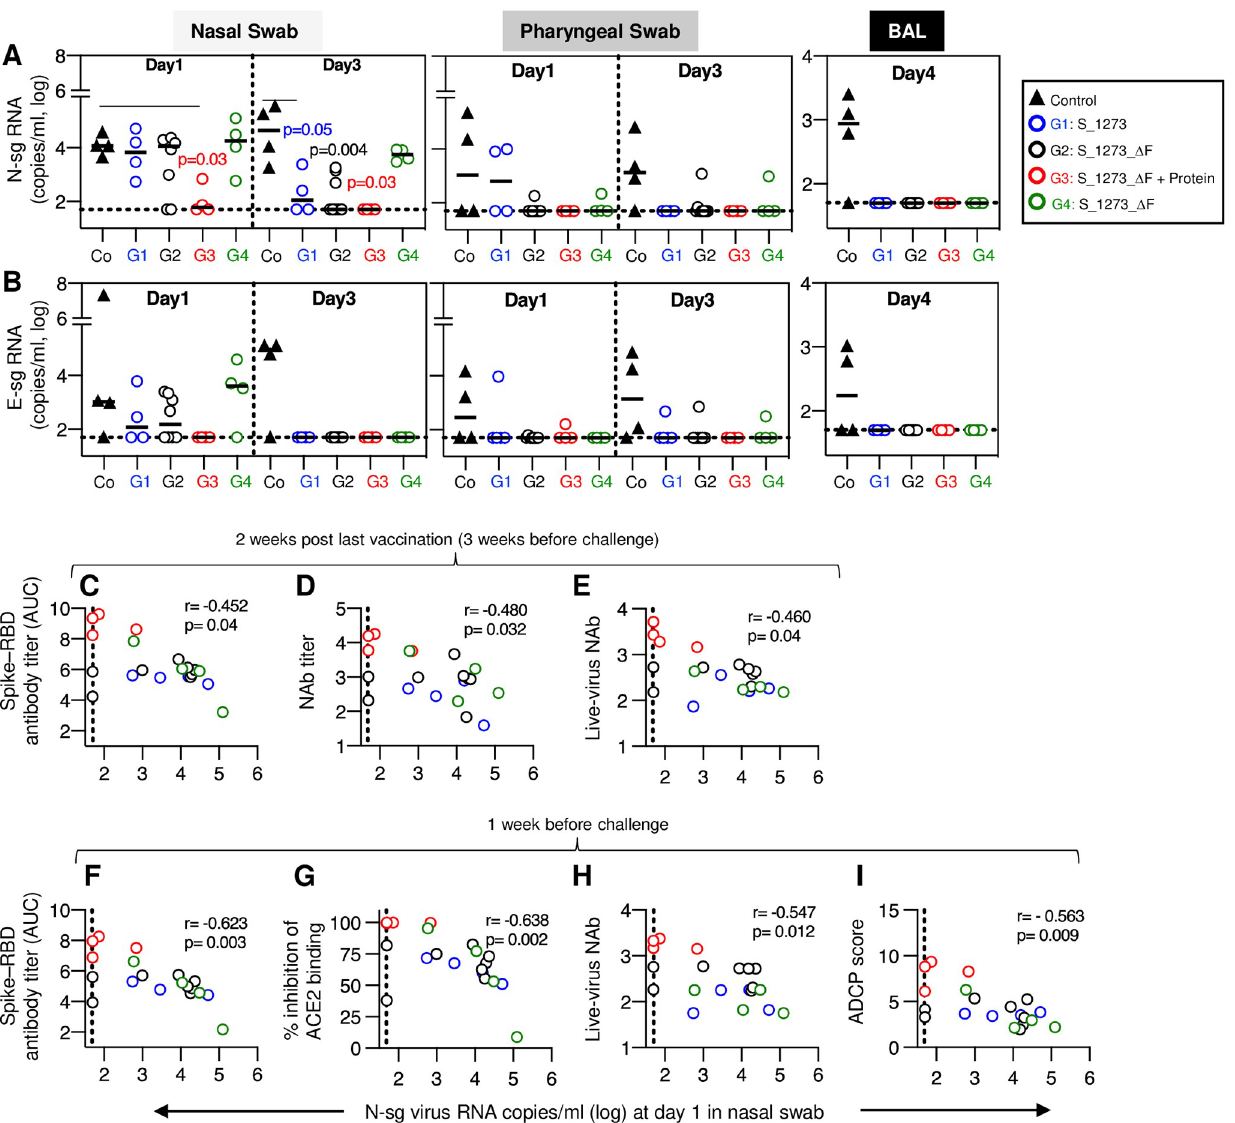
Fig 4. Virus loads and immune response in rhesus macaques challenged with infectious SARS-CoV-2 virus. ( A, B ) Virus load measurements upon reverse transcription polymerase chain reaction (RT-PCR) targeting ( A ) N-subgenomic (sg) RNA and ( B ) E-sg RNA isolated from nasal swabs (left panels) and pharyngeal swabs (middle panels) collected at day 1 and day 3 post-challenge and from bronchoalveolar lavage (BAL, right panels) collected at day 4 are shown. The p values (color-coded) denote significance of virus loads comparing vaccinees to controls analyzed at day 1 and 3 postinfection in nasal swab using the N-sg assay. Median values are indicated. ( C-I ) Univariate correlations of virus loads in nasal swabs on day 1 post challenge and antibody measurements in samples collected (C-E) 2 weeks after the last vaccination (representing 3 weeks before challenge) and (F-I) one week prior to challenge are shown with ( C, F ) Spike-RBD ELISA antibody titers (AUC); ( D ) reciprocal pseudotype NAb ID50 titer (log); ( E, H ) reciprocal live-virus NAb titer (ID50, log); ( G ) % inhibition of ACE2 binding to Spike-RBD; ( I ) ADCP score. Dotted line denotes threshold of the assay ( < 50